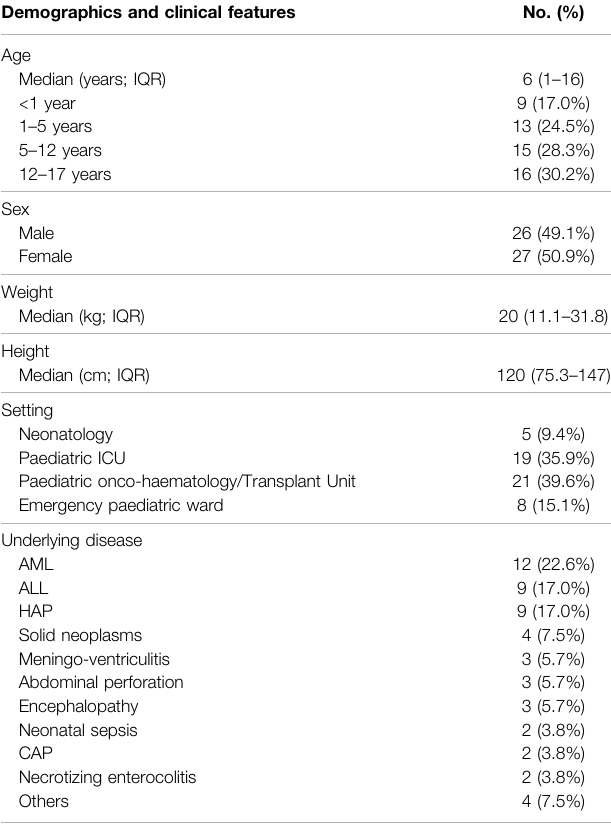
TABLE 2 | Clinical and demographics features of paediatric patients in which at least one CPA for antimicrobial dosing adjustment was performed. Demographics and clinical features